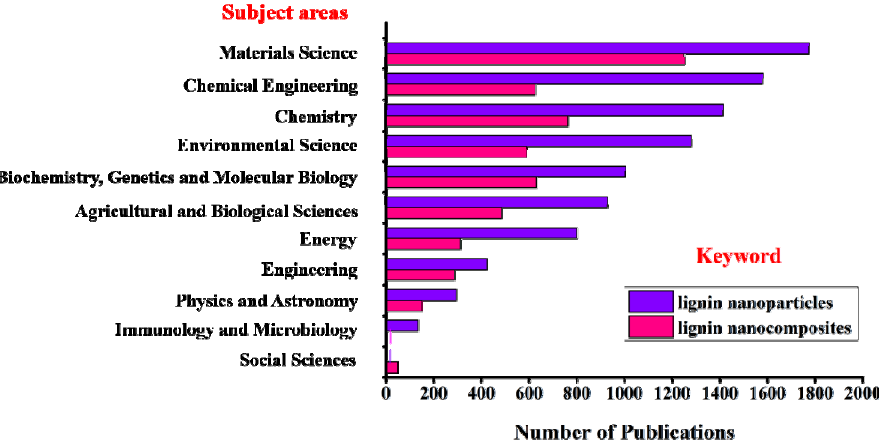
Figure 3. The number and subject areas of published literature over the last 5 years indexed in ScienceDirect using the keyword “lignin nanoparticles” and “lignin nanocomposites”.